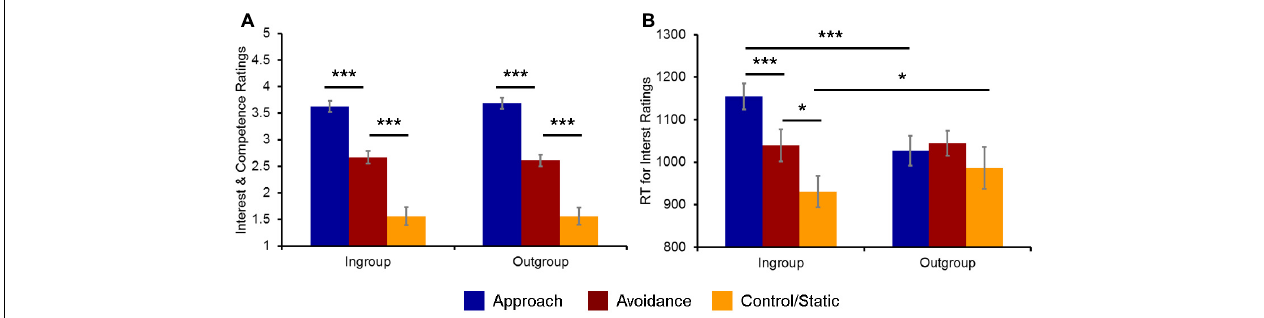
FIGURE 2 | Behavioral indices of the evaluation of ingroup and outgroup social encounters. (A) Participants’ ratings of competence and interest for approach, avoidance, and static non-verbal behaviors were overall similar across ingroup and outgroup social encounters. (B) Participants’ RTs for evaluating their interest in doing business were significantly faster/slower for ingroup static/approach behaviors, respectively, compared to the corresponding outgroup conditions. ∗ p < 0.05, ∗∗∗ p < 0.001.